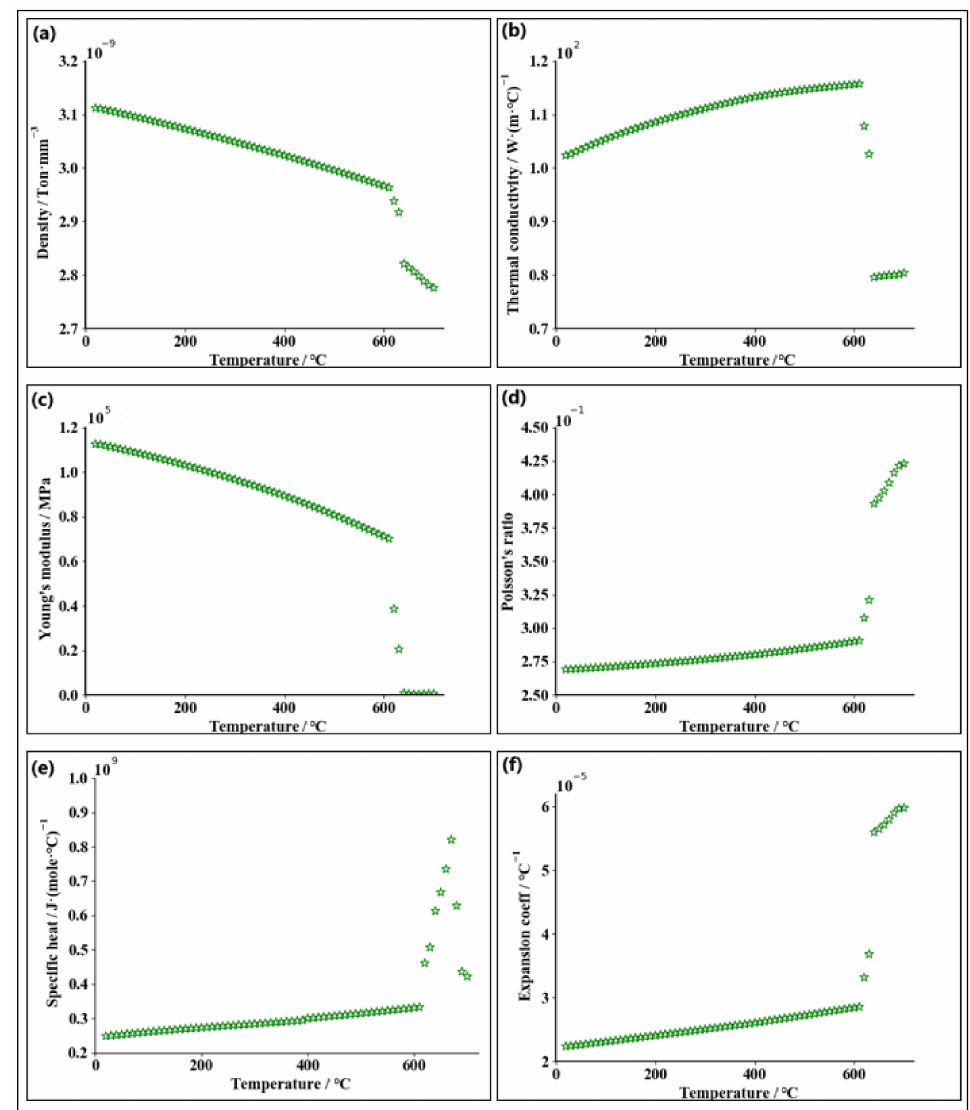
Figure 3. The characterization results of ( a ) density; ( b ) thermal conductivity; ( c ) Young’s modulus; ( d ) Poisson’s ratio; ( e ) specific heat; ( f ) thermal expansion